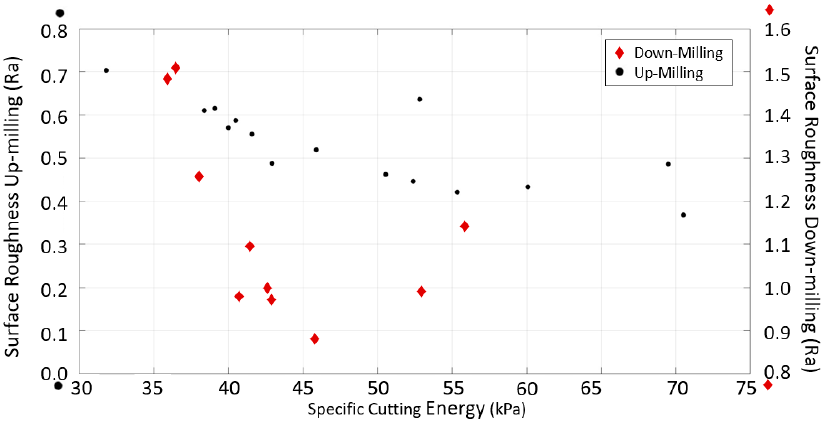
Figure 11. Surface roughness vs. specific cutting energy correlation for sample 4 made of CRS ma ‐ terial.